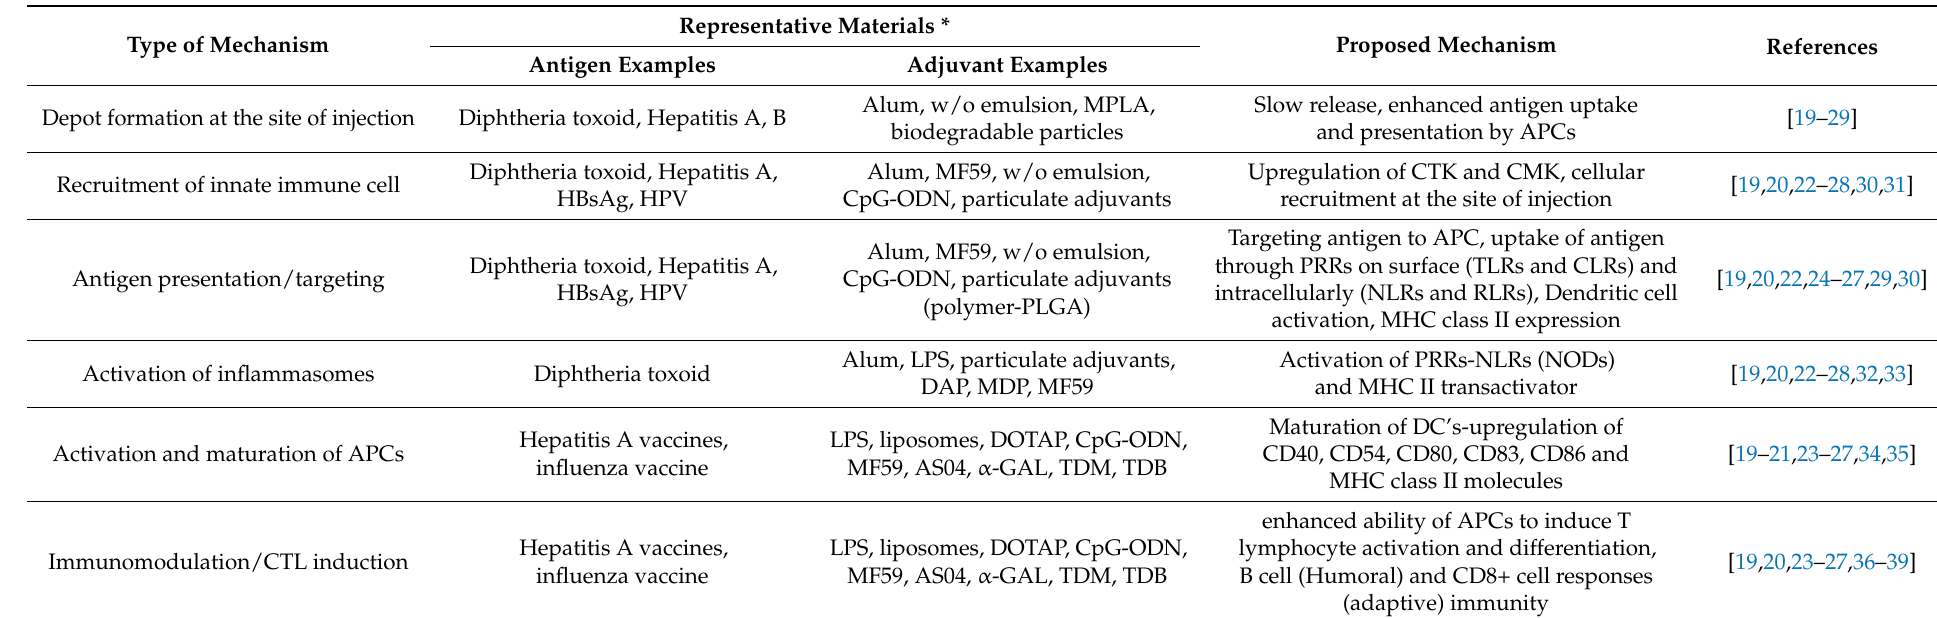
Table 1. Mode of action of adjuvants and delivery vehicles.